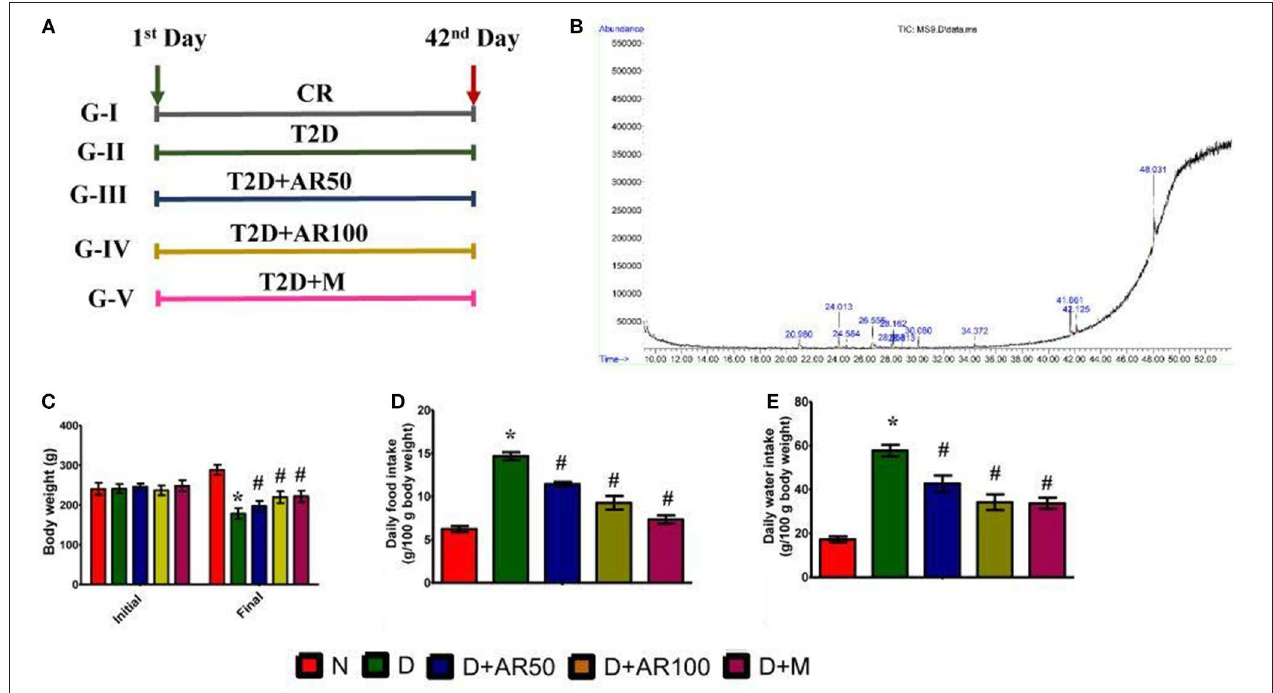
FIGURE 1 | (A) scheme of treatment, CR = Control rats; T2D = type 2 diabetic rats; T2D + AR50 = Type 2 diabetic rats + 50 mg/kg bw of A. reticulata seed ethanolic extract; T2D + AR100 = Type 2 diabetic rats + 100 mg/kg bw of A. reticulata seed ethanolic extract; T2D + M = Type 2 diabetic rats + Metformin; (B) GC-MS chromatogram of ethanolic seed extract of Annona reticulata L; Effect of Annona reticulata L on (C) Body weight (D) Daily food intake, and (E) Daily water intake. Each value is mean ± SD of six rats in each group. *significant compared to normal control group p < 0.01. # significant compared to diabetic group p <